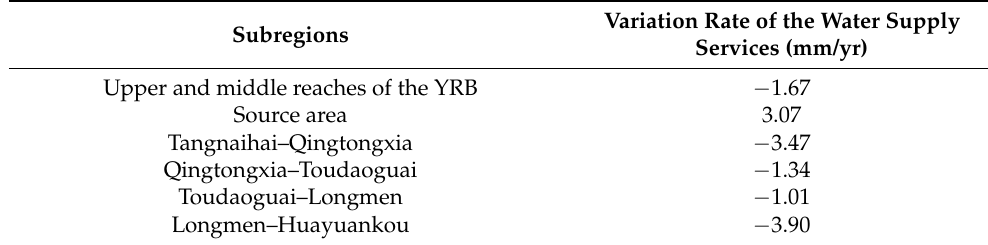
Table 5. Variations in the ecosystem water supply services in the upper and middle of the YRB during